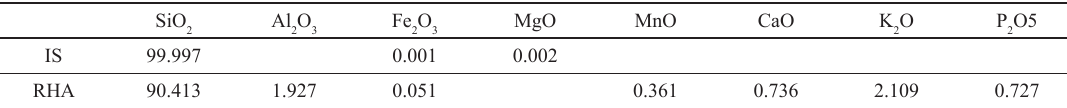
Table 1. XRF results of RHA and IS.